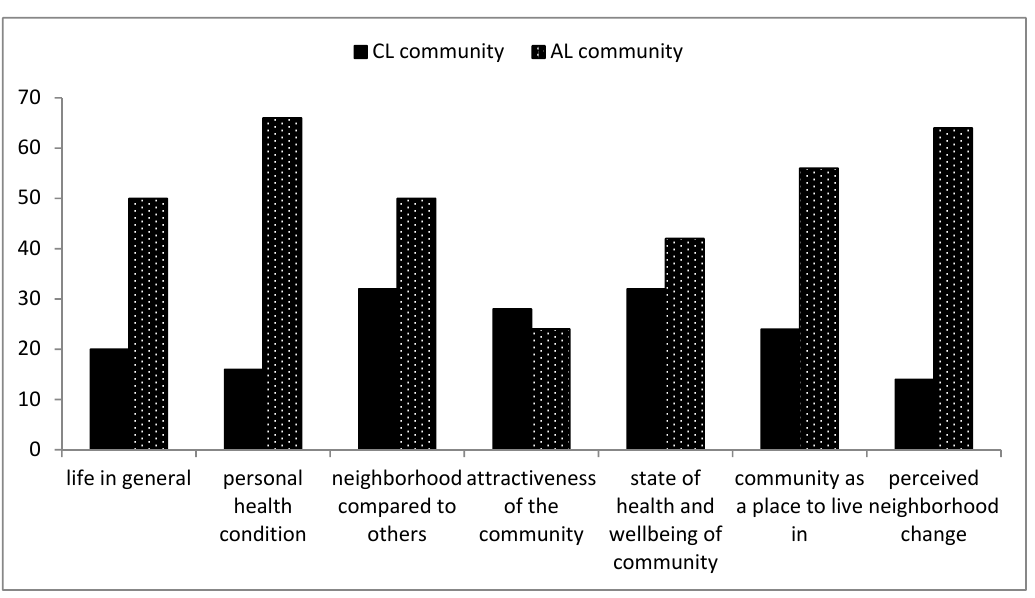
Figure 11. Comparison between both communities showing how disturbing these external factors were to them.